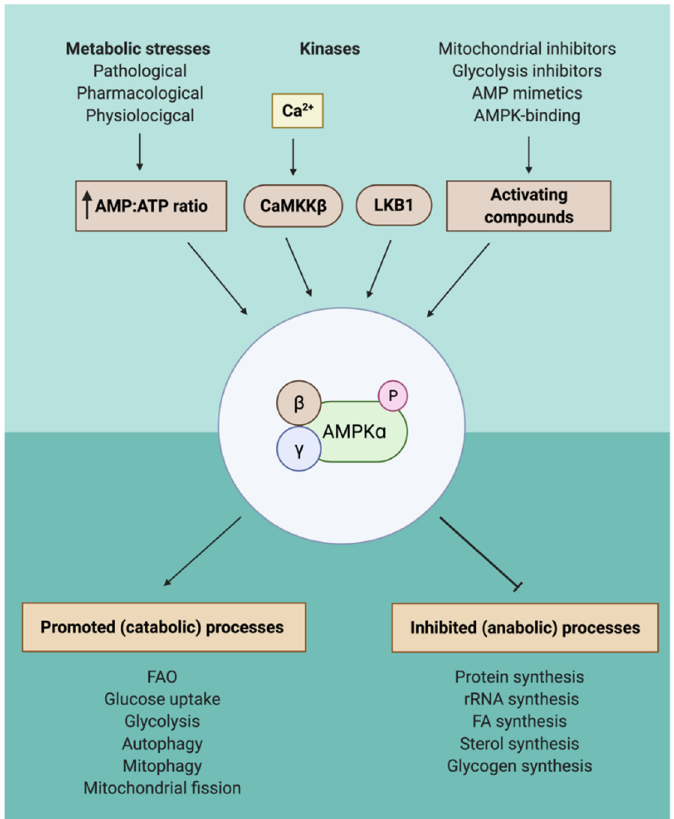
Figure 1. Functional mechanism of upstream regulation of AMPK. Phosphorylation of AMPK can be caused by an increased AMP:ATP ratio, the kinases CaMKK β and LKB1, and activating components. Elevated ratios of AMP:ATP are caused by metabolic stresses, which can be divided into pathological, pharmacological, and physiological pathological stresses. CaMKK β is activated by increased intracellular Ca 2+ . Examples of activating compounds are mitochondrial and glycolysis inhibitors, AMP-mimetics, and AMPK-binding compounds. Activation of AMPK will stimulate catabolic processes, leading to ATP production, and inhibit anabolic processes, leading to less ATP consumption. Some examples of the metabolic consequences are shown. Abbreviations: adenosine monophosphate, AMP; adenosine triphosphate, ATP; AMP-activated protein kinase, AMPK; CaM- dependent protein kinase kinase beta, CaMKK β ; fatty acids, FA; fatty acid oxidation, FAO; liver kinase B1,